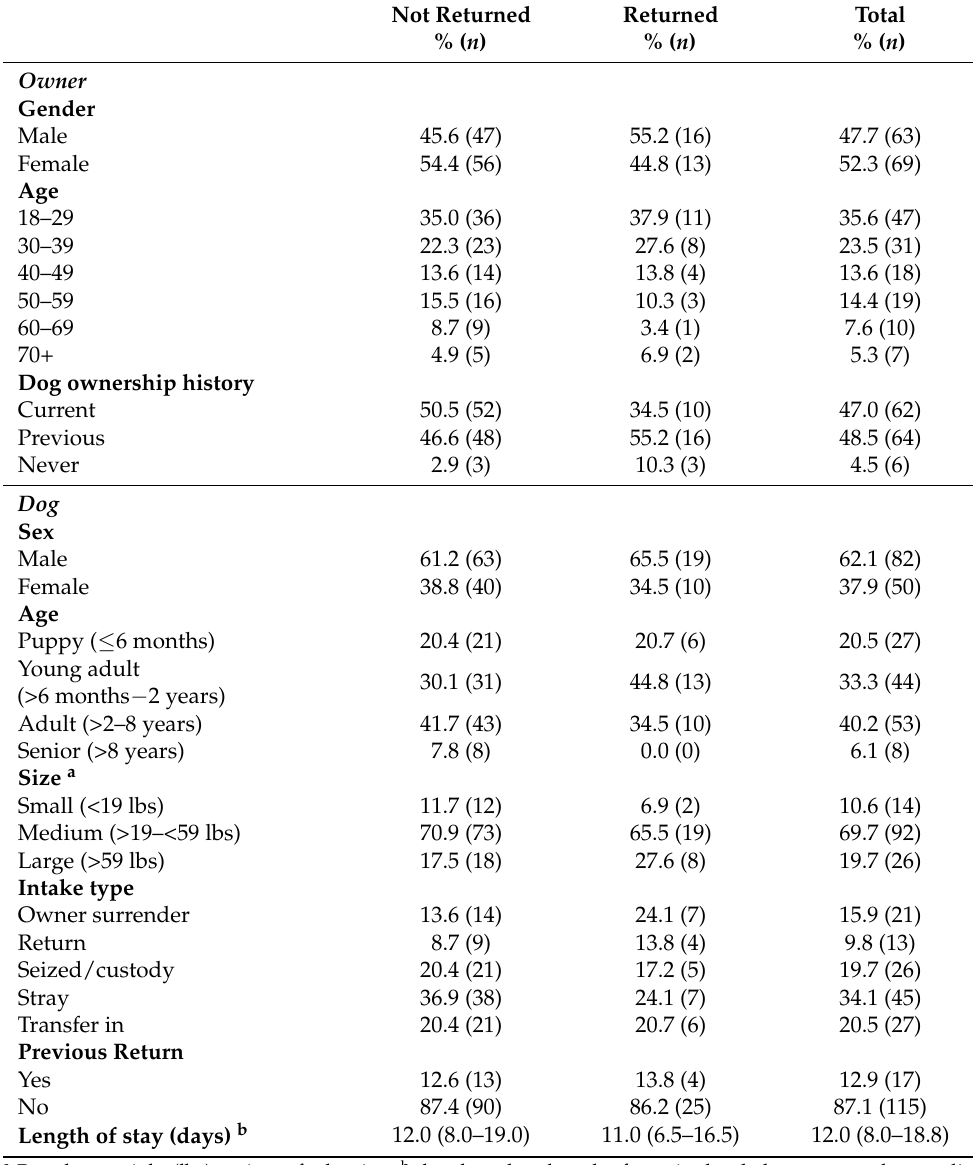
Table 1. Study characteristics of owners and adopted dogs ( n = 132).